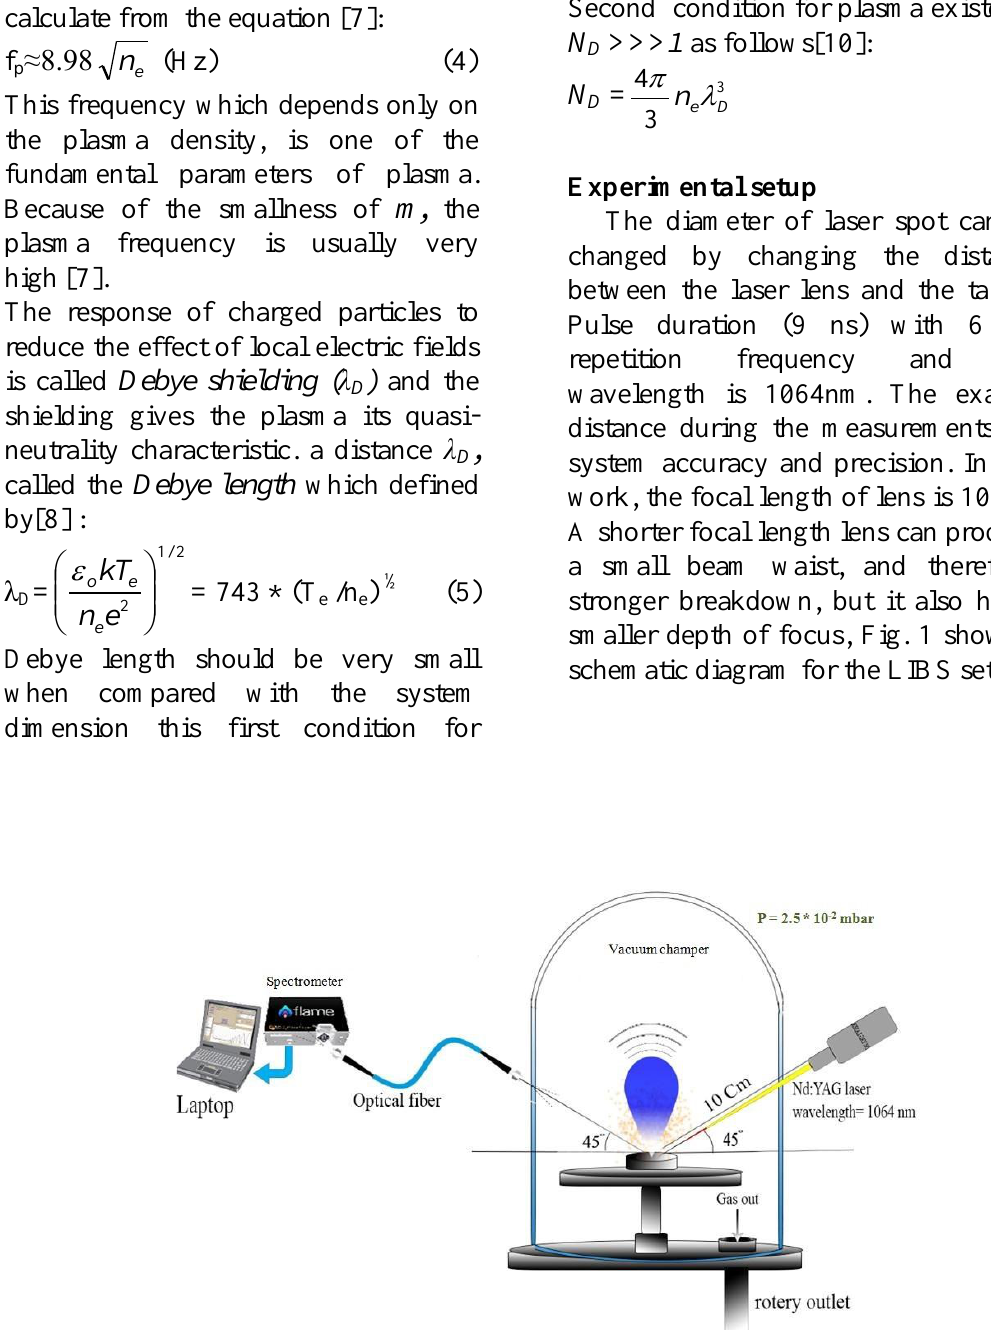
Fig. 1: Laser Induced Plasma Spectroscopy (LIPS) System